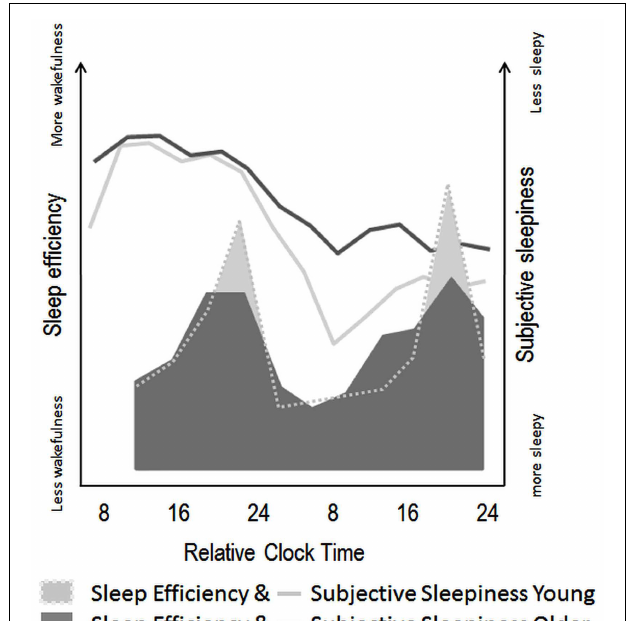
FIGURE 3 | Schematic illustration of age-related modifications in circadian and homeostatic sleep-wake regulation in humans. Filled areas illustrate variations in sleep efficiency over a nap protocol (10 episodes of 150min of wake, followed by 75min of scheduled sleep episodes) modified from Münch et al. (2005). Circadian sleep-wake promotion, as expressed by the amount of wakefulness throughout nap episodes seems attenuated in older (dark gray) as compared to young individuals (light gray area). Line plots indicate the superimposed time course of subjective sleepiness over a 40-h sleep deprivation protocol in young (light gray line) and older (dark gray line) adults [modified from Adam et al. (2006)].These values indicate less pronounced effects of increasing homeostatic sleep pressure on subjective sleepiness in older, as compared to young